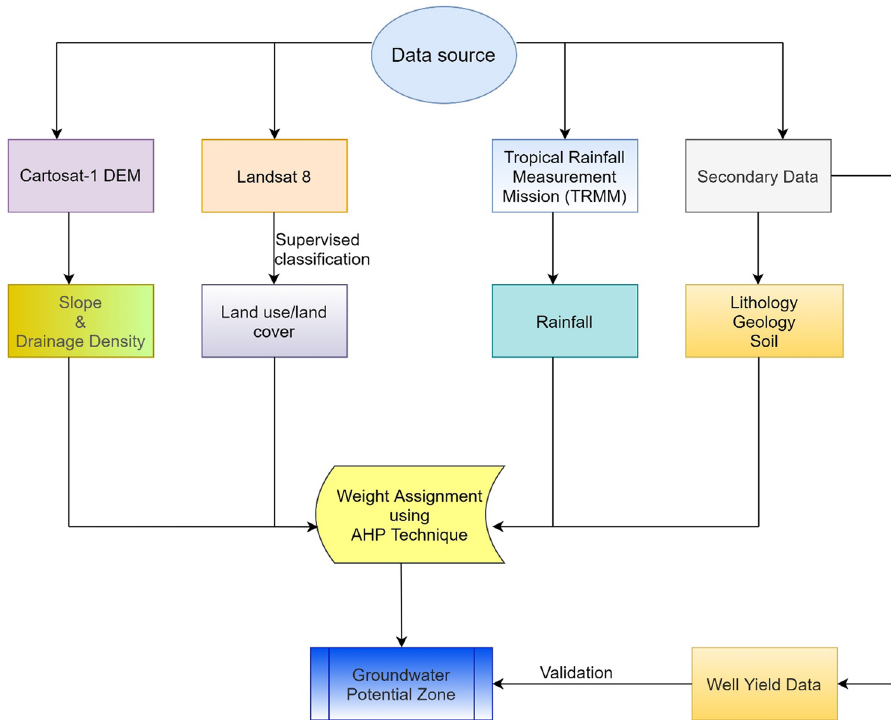
Fig. 2 Flow chart of methodol-